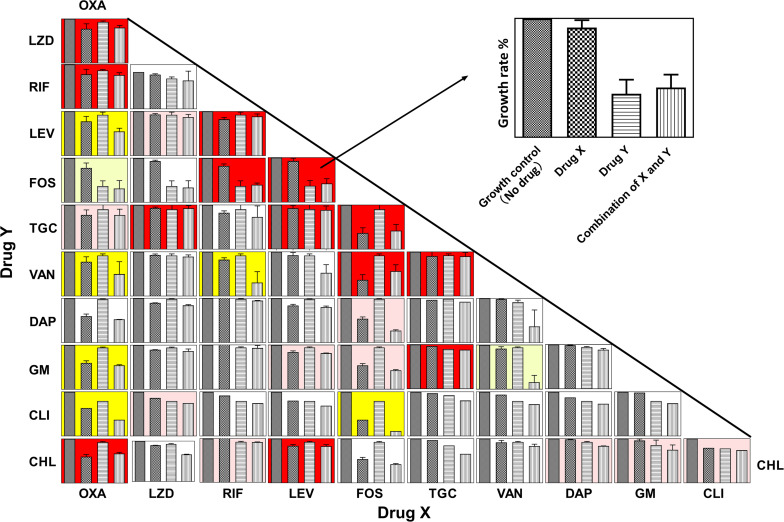
Panels of pairwise combinations for 11 antibiotics. Growth rates of no-drug, drug X only, drug Y only, and combinations of X and Y are shown in each panel (Upper right corner: zoom in on each panel). Error bars represent variability in replicate measurements. Synergism (ε~ < −0.5), antagonistic (ε~ > 0.5), and additive (−0.25 < ε~ < 0.5 and −0.5 < ε~ < 0.25) effects are labeled with yellow, red, and white backgrounds in the corresponding panels. Panels with pink and light-yellow color represent antagonistic buffering (0.25 < ε~ < 0.5) and mild synergistic interactions (−0.5 < ε~ < −0.25), respectively.